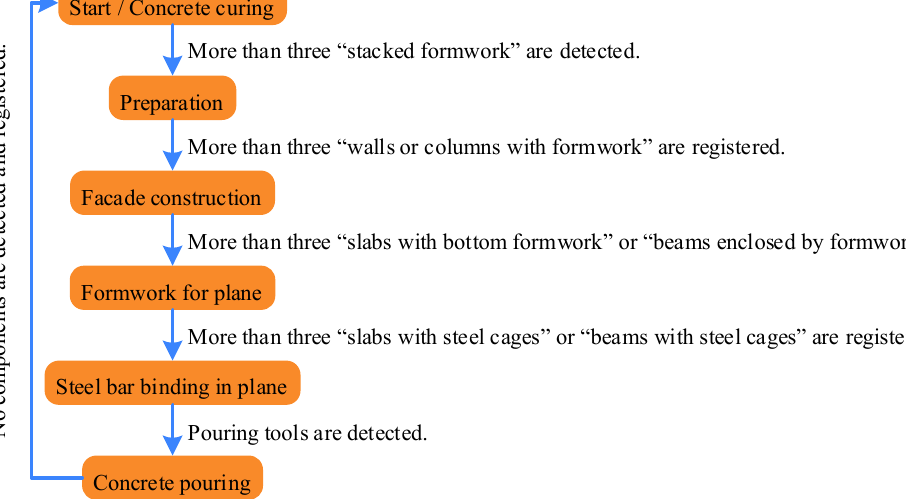
Figure 7. Stage update conditions.